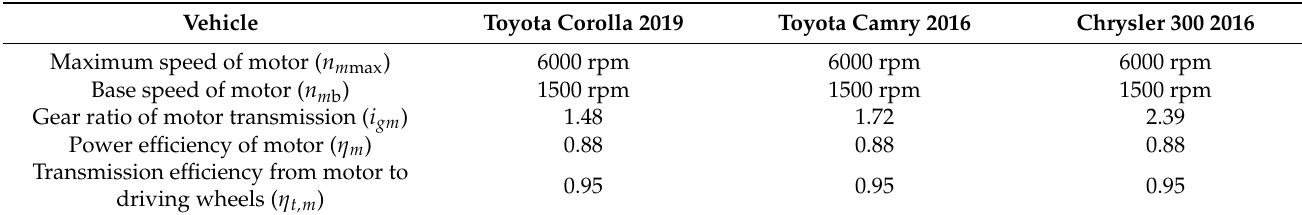
Table 2. Parameters of designed electric motors for hybridization of three typical IC engine vehicles.